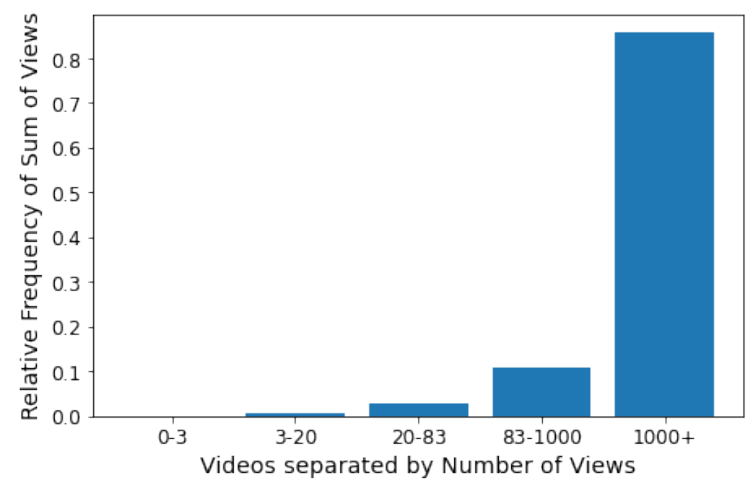
Figure 4. Percentage of total views separated by five classes of number of views.